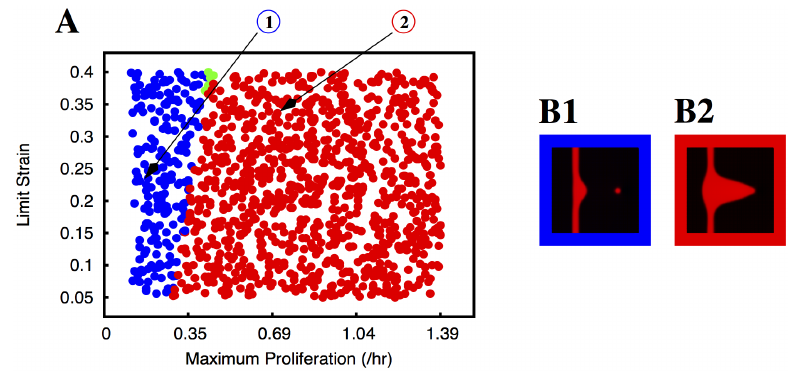
Fig 4. Morphology of the growing sprouts with endothelial cell proliferation dependent on local strain. In plate A we indicate the morphology of the growing sprout (by using different colours) for different values of maximum proliferation ( M P ) and limit strain ( L S ). In these simulations the proliferation rate increases linearly with the strain until it reaches the value M P at the strain L S . The colours indicate the morphology of the observed sprouts for the corresponding parameters: blue dots correspond to situations where the sprout is split and the red dots correspond to deformed vessels (i.e. triangular sprouts). The few green dots correspond to well formed sprouts without appreciable thickening of the parental vessel. We observe that the sprout breaks for low proliferation rates, and it becomes deformed for large proliferation rates; the region of parameters that produce good sprouts is extremely small. In plates B1 and B2 we plot examples of the morphologies observed (the color of the border in these plates follows the same code as in plate A). The parameters used to obtain the morphologies depicted in B1 and B2 are indicated by arrows in plate A.